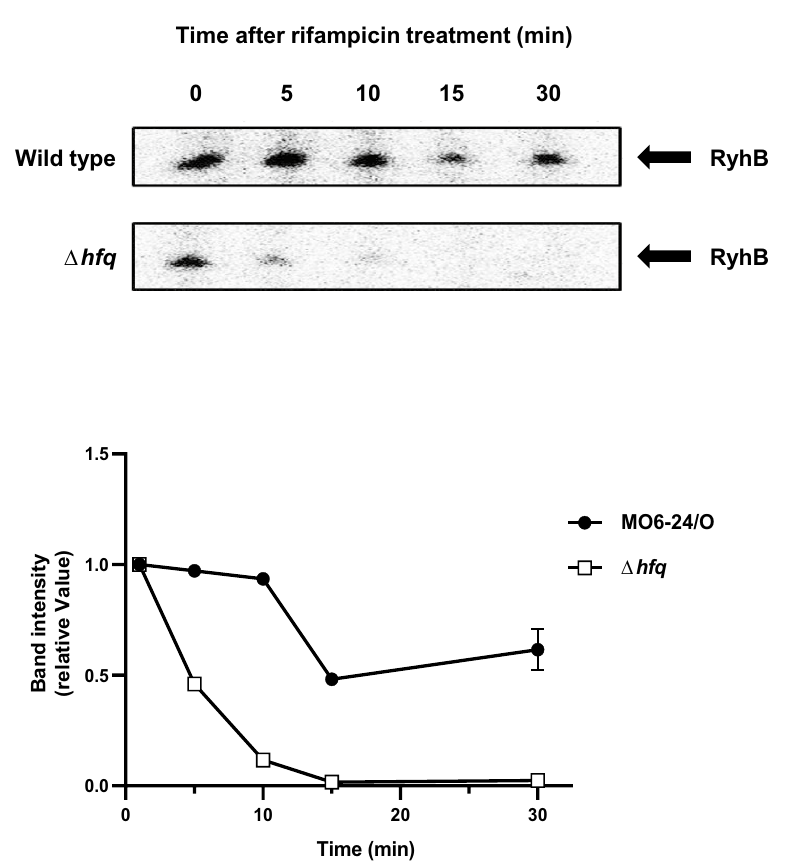
Figure 1. Hfq stabilizes the transcript of ryhB . V. vulnificus MO6 and hfq mutant (Δ hfq ) were cultured in LB broth for 3 h, at which point 200 μM of 2, 2 ′ -dipyridyl was added and incubation continued for another hour. Samples were then treated with 250 g/ml of rifampicin and collected at time intervals for RNA quantification. Intensities of bands were quantitatively measured using a densitometer and the results are shown as a graph in the lower